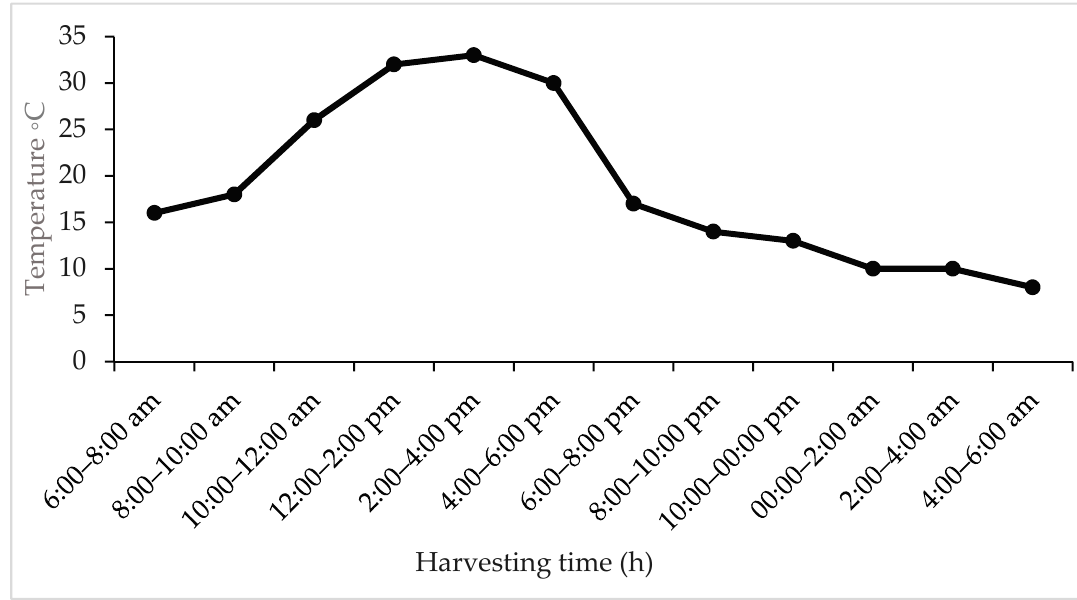
Figure 1. Averages of the air temperatures during the collecting times of S. officinalis.